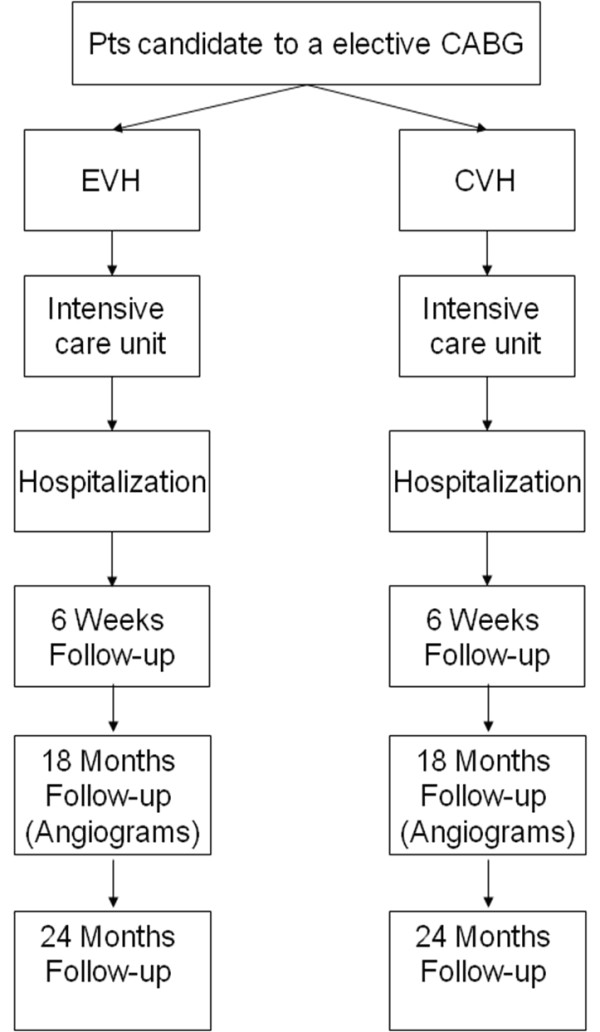
Flowchart of the study design. This figure illustrates the study design.